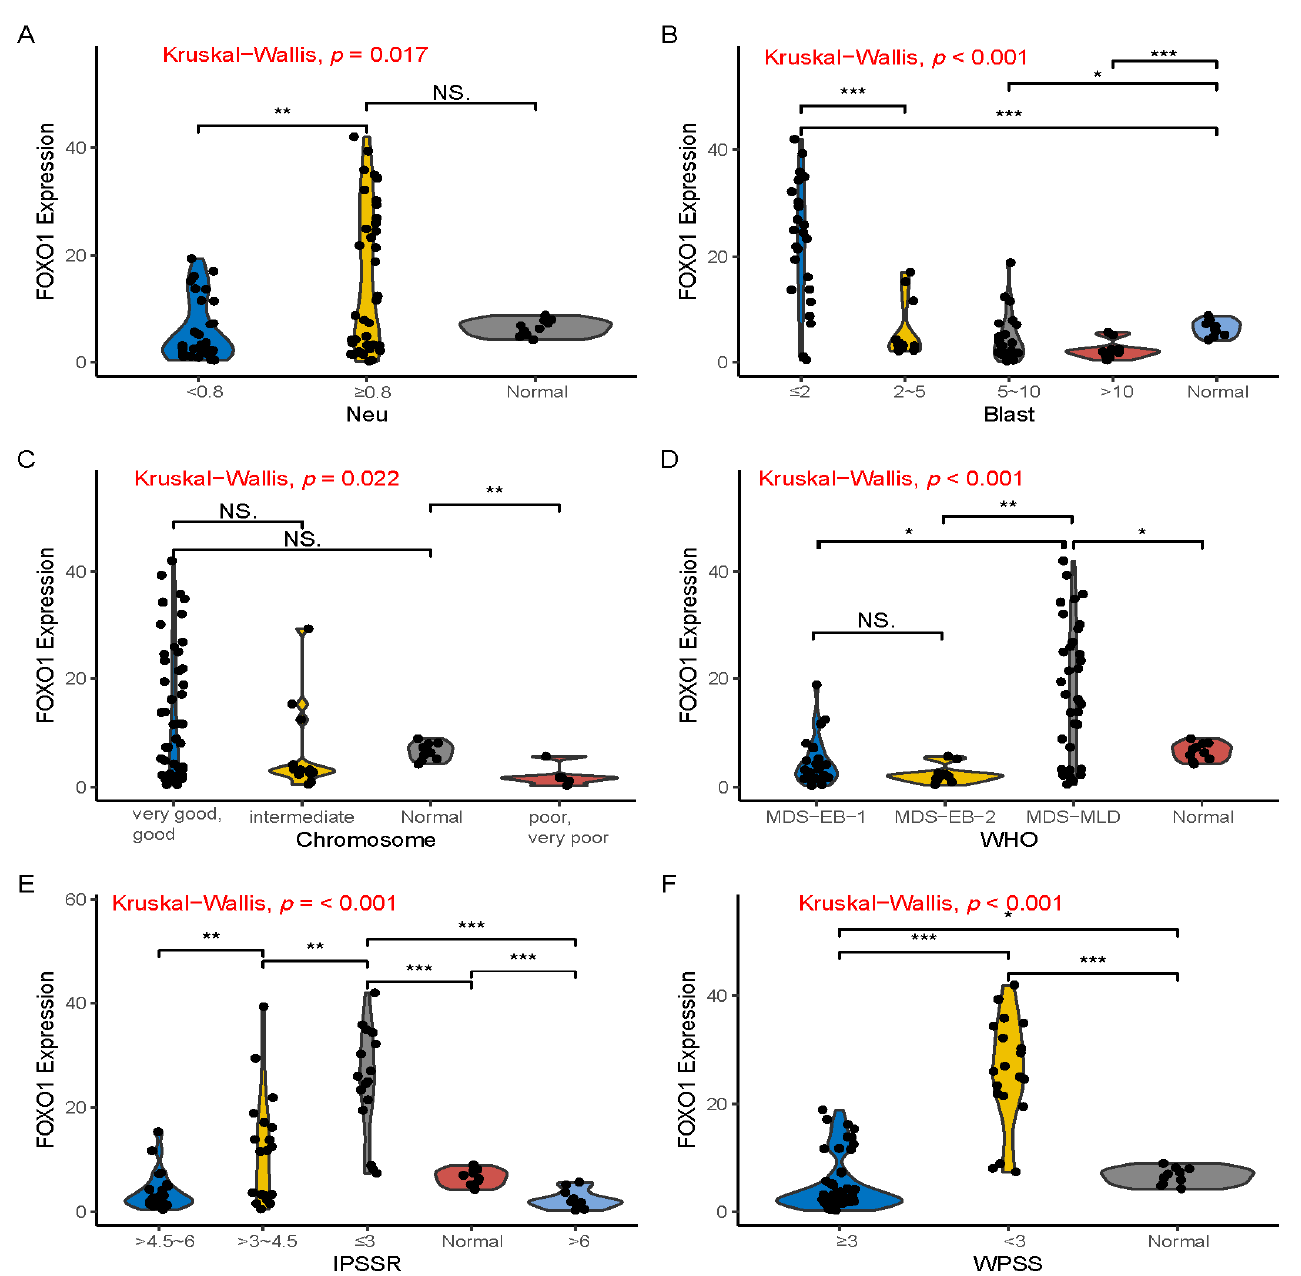
Figure 1. FOXO1 expression in MDS with different clinical features. ( A ) showed that the higher neutrophil count group had increased FOXO1 expression than lower neutrophil count group in MDS. ( B ) showed a significant decrease in FOXO1 expression with an increase in MDS bone marrow blasts, and the expression of FOXO1 in bone marrow blasts greater than 10% was significantly decreased in MDS patients. ( C ) showed that MDS patients with very good, good karyotypes had significantly higher FOXO1 expression than patients with poor, very poor karyotypes. ( D ) showed that FOXO1 expression was significantly higher in MDS-MLD patients than in MDS-EB1 and EB2 patients. ( E , F ) showed FOXO1 expression in lower-risk MDS was significantly higher than higher-risk MDS patients according to IPSSR and WPSS scoring systems. * means p < 0.05, ** means p < 0.01, *** means p < 0.001, NS means no significance. Abbreviations: Neu, neutrophil; WHO, World Health Organization; MDS-SLD, MDS-single lineage dysplasia; MDS-MLD, MDS-multilineage dysplasia; MDS-EB1, MDS-excess blasts-1; MDS-EB2, MDS-excess blasts-2; WPSS, WHO classification-based Prognostic Scoring System; IPSSR, Revised International Prognostic Scoring System.